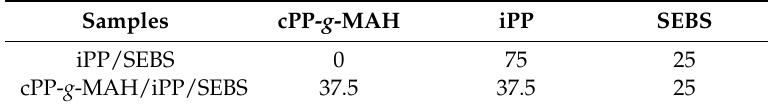
Table 1. Blend contents for preparing composite samples (wt.%). cPP- g